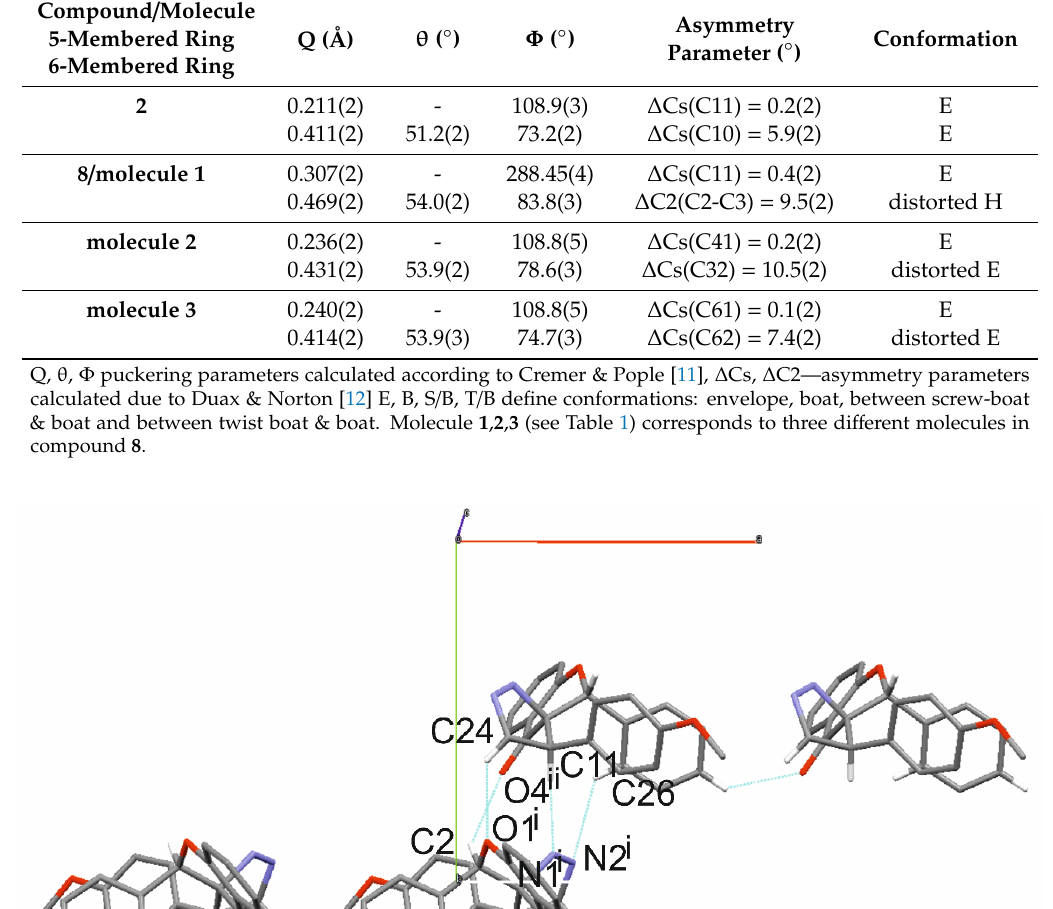
Figure 4. Partial molecular packing of 8 showing the 3-D network of hydrogen bonds. 2.3. Experimental Lipophilicity of the Synthesized Flavone Analogues Lipophilicity is one of the most important physicochemical properties in pharmaceutical research. It can be considered a key determinant of the pharmacokinetic properties of a drug. It is commonly measured by the partition coefficient between water and n -octanol, being expressed as log P [14]. The coefficient log P shows the affinity of a molecule for a lipophilic environment [15,16]. Knowledge of the partition coefficient is valuable: it is frequently used in structure–activity